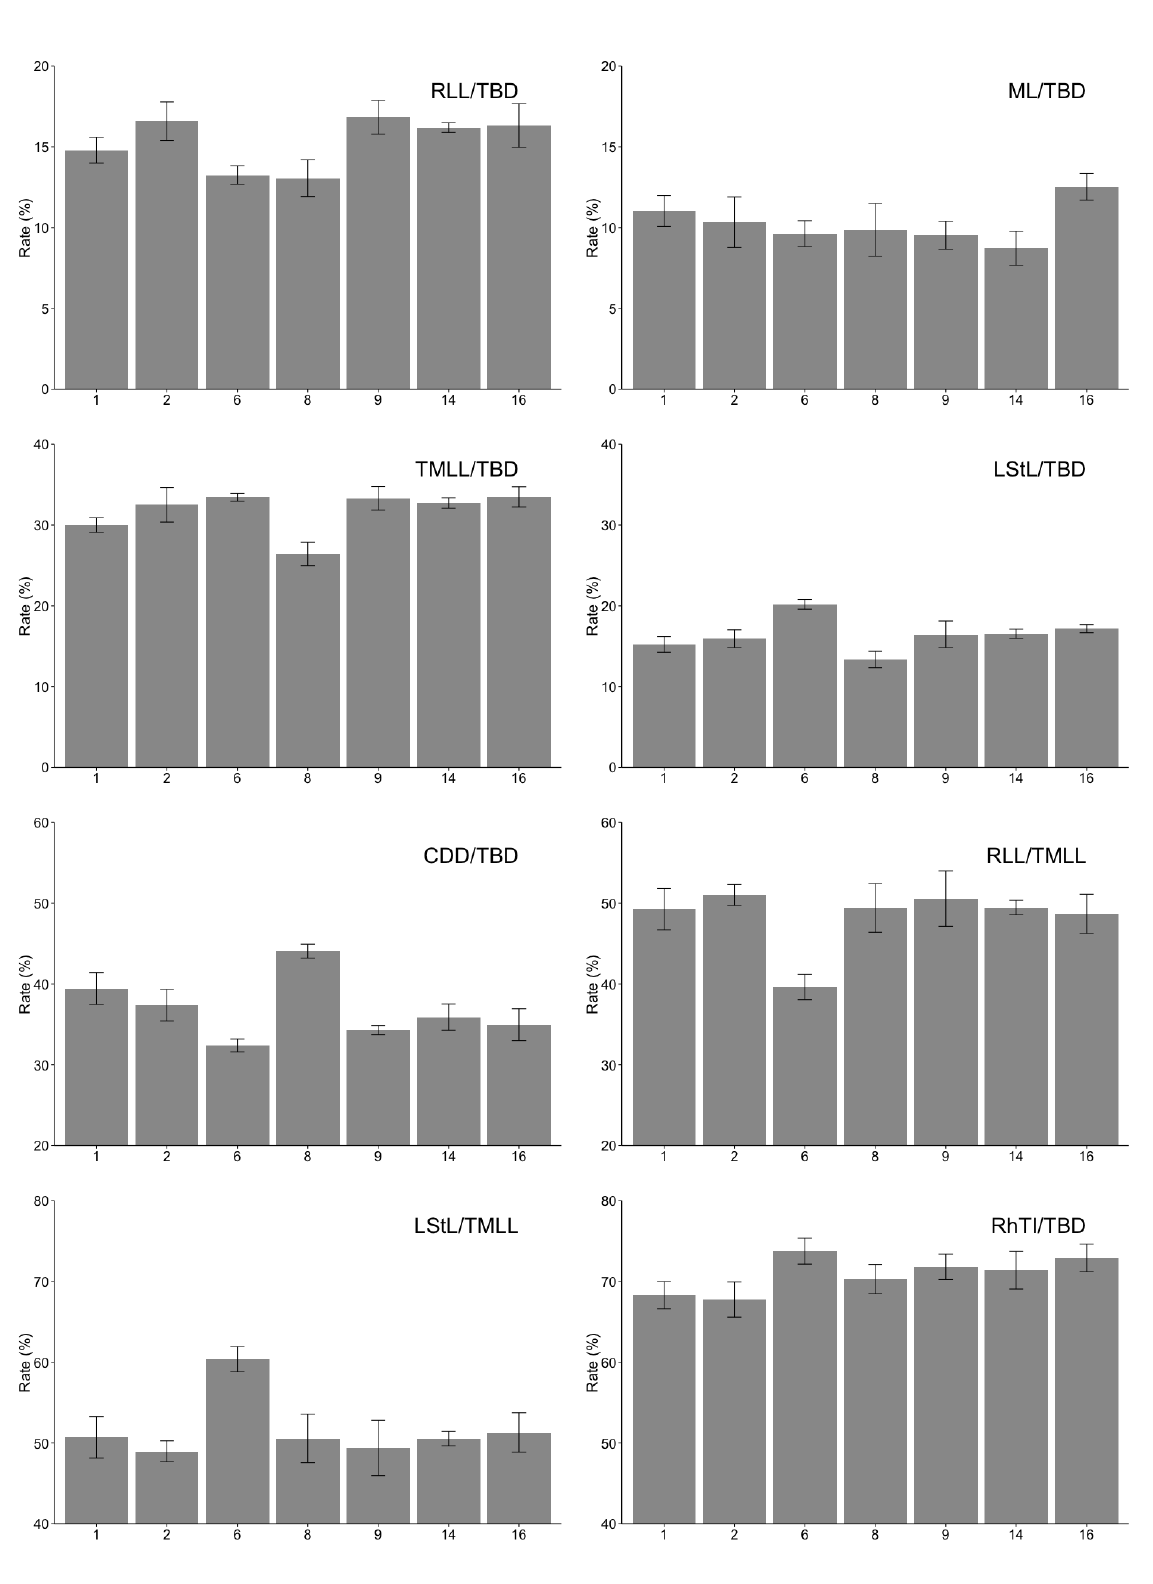
Fig. 3. Body proportions of ephyrae (shown as percentages). Error bars show standard deviation. Abbreviations: see Table